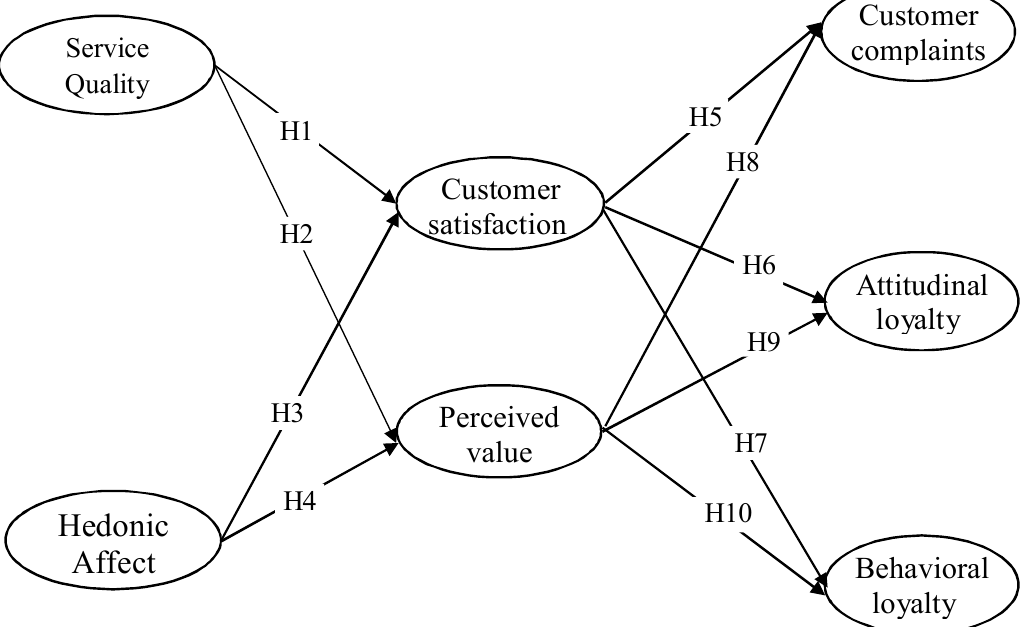
Fig. 1. Research conceptual